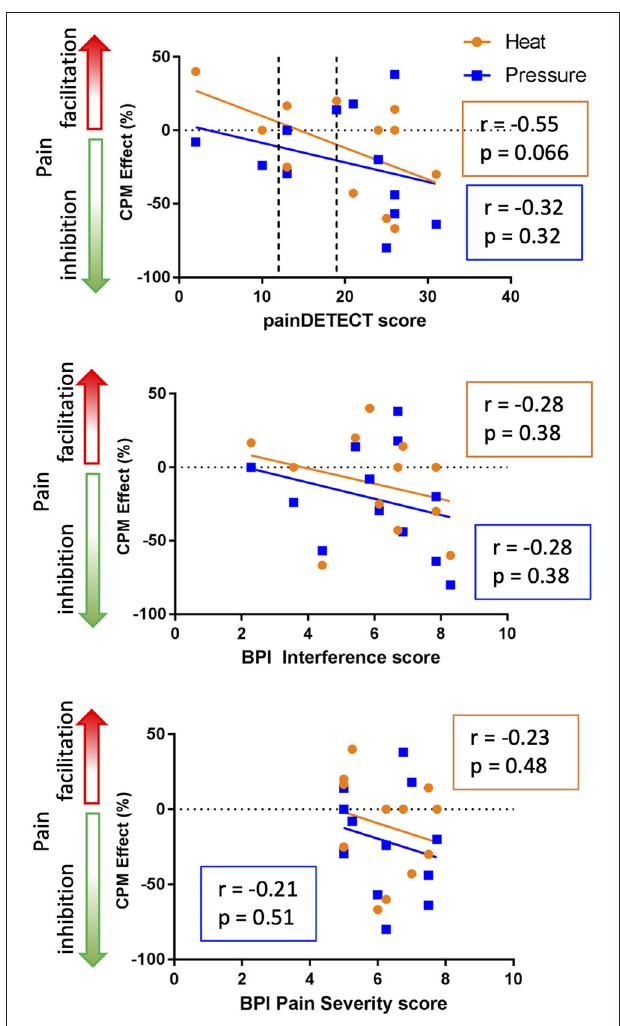
FIGURE 5 | Relationship between clinical pain and CPM. The top graph indicates that there is a trend toward greater inhibitory heat-based CPM effects in those people with higher levels of neuropathic pain based on PainDetect ( r = − 0.55, p = 0.066). In the painDETECT questionnaire scores 12 or lower to indicate non-neuropathic pain, 13–18 mixed neuropathic pain, and 19 or greater indicates the presence of neuropathic pain is likely (categories indicated by the dotted lines). The middle and bottom graphs depict the relationship between CPM and the Brief Pain Inventory (BPI) interference and pain severity scores. The BPI interference and pain severity scores are negatively correlated with CPM effect but neither of these correlations are significant ( p <